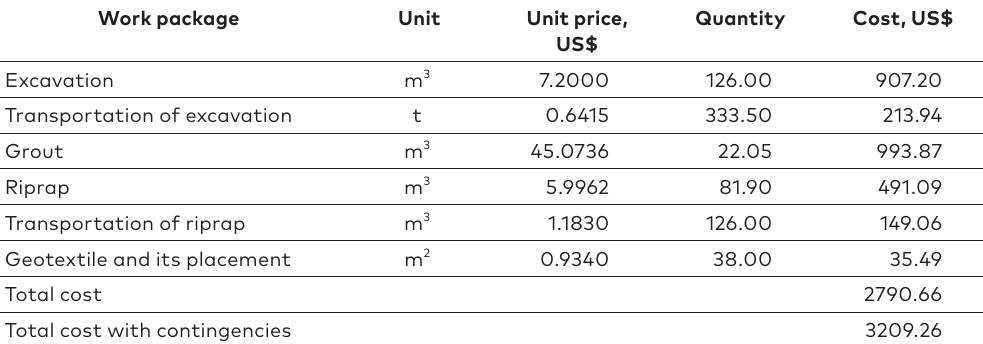
Table 4. Unit prices and costs of partially grouted